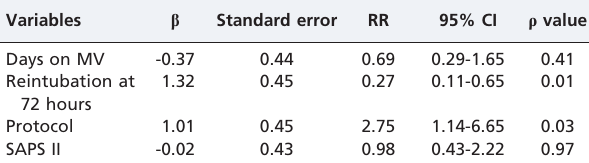
Table 4 - Multivariate analysis for survival using the Cox proportional hazards regression model.